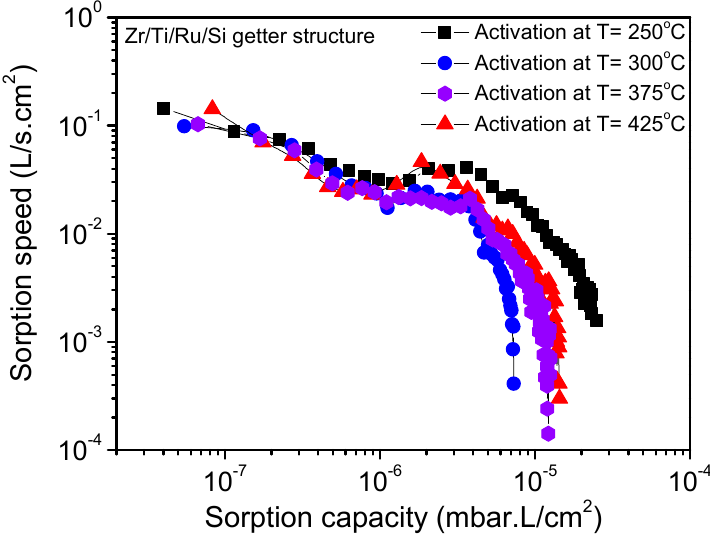
Figure 10. Sorption characteristics of the multilayered Zr/Ti/Ru/Si NEG after different activation temperatures for one hour.